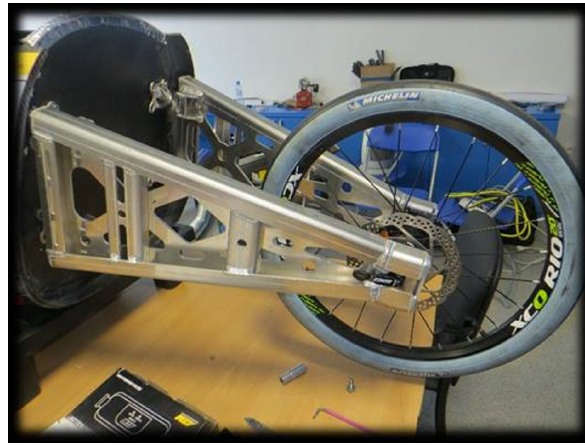
ing. Such a solution greatly facilitated access to the engine and all sensors if it is necessary during the race for repairs.